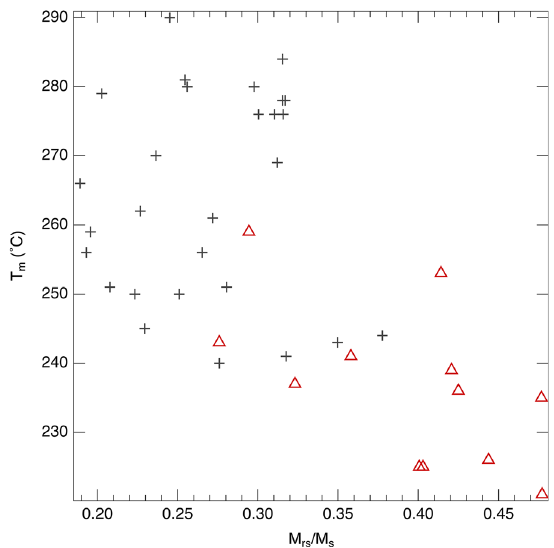
Fig. 5 T m vs. M rs /M s of the ash samples. The HOND and KAF samples from June 6, 2020, in which no Ti-rich titanomagnetite was identified, were removed. Red triangles denote volcanic ash results when volcanic glow event was observed and gray crosses indicate those collected